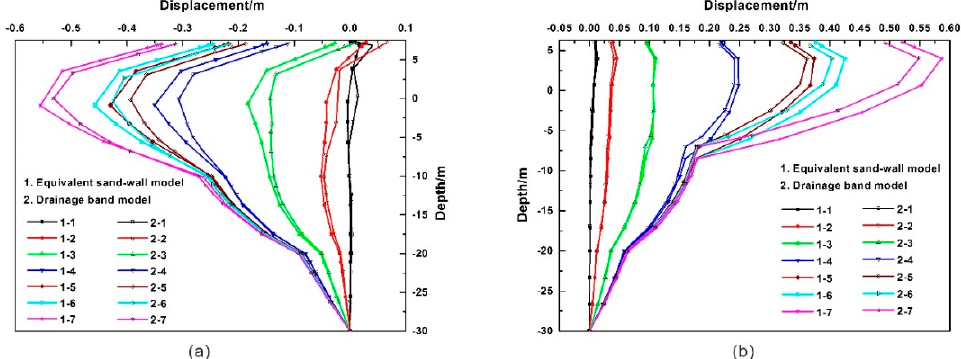
Figure 14. Horizontal displacement curves of the toe of the new subgrade and old embankment: ( a ) A point; ( b ) F point.